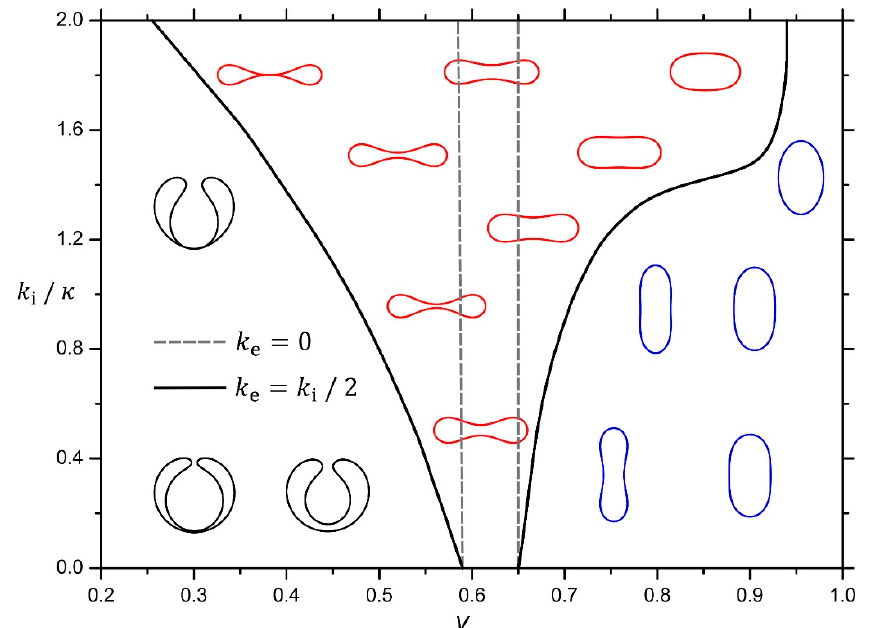
Figure 6. Stability diagram of equilibrium closed membrane shapes as a function of relative volume v in the presence ( k e = k i /2, solid line) and in the absence ( k e = 0, dashed line) of the extrinsic contribution. Profiles of stable shapes presented in the diagram for different values of the reduced volume v and k i / к were calculated in the presence of the extrinsic term ( k e = k i /2). Stomatocyte shapes are colored in black, oblate shapes (including discocyte shapes) in red and prolate shapes in blue. 𝑅/𝜉 = 7 .